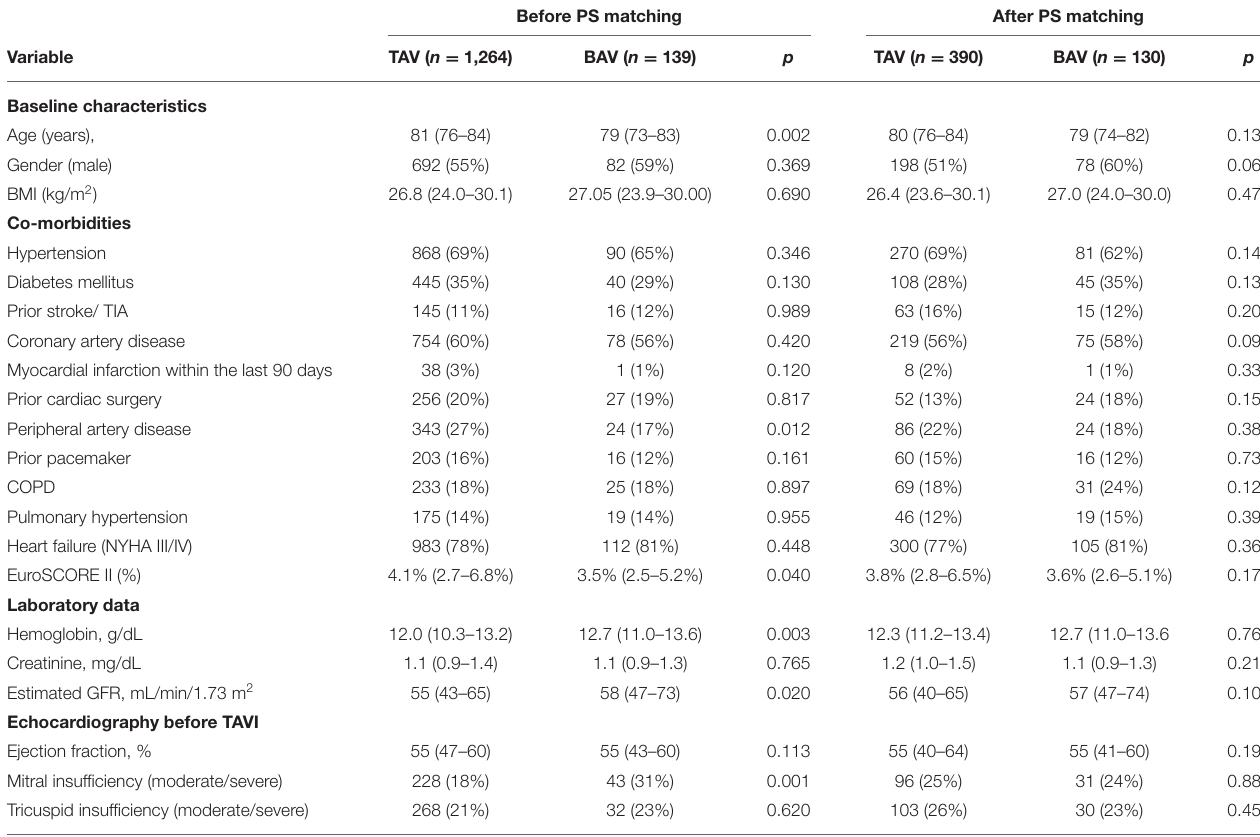
TABLE 1 | Baseline characteristics before and after propensity score matching.